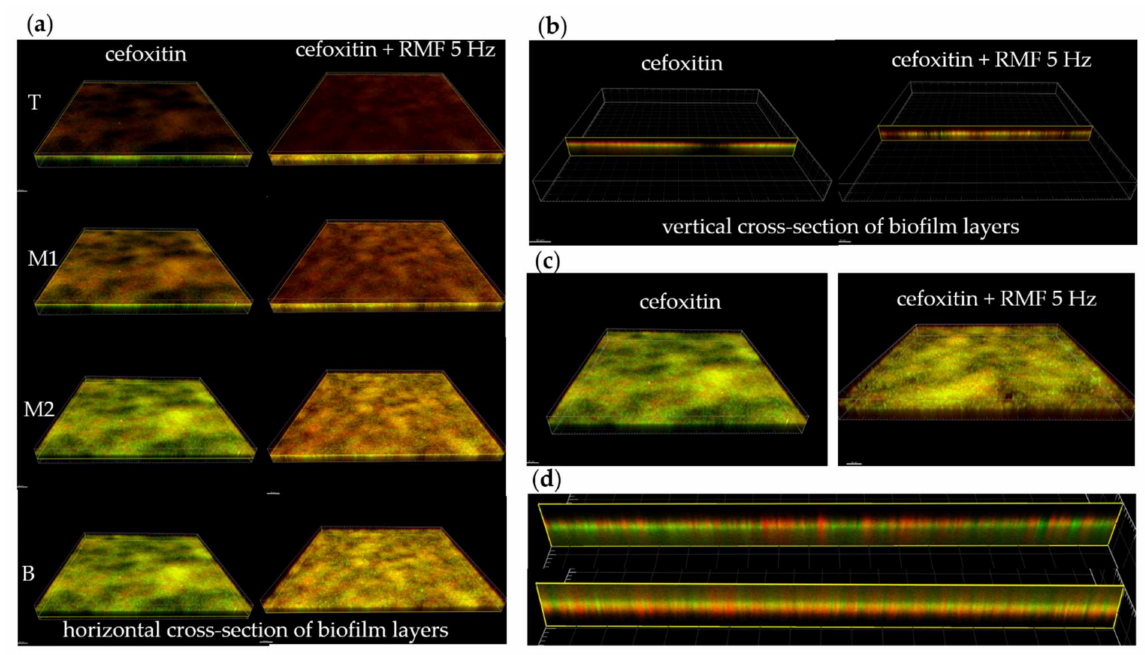
Figure 4. The distribution of staphylococcal cells with intact walls (green color) and with altered walls (red/orange color) in the biofilm of MRSA ATCC 33591 strain; ( a ) horizontal cross-sections of top, middle and bottom (T, M1, M2, B, respectively) layers of biofilm exposed to cefoxitin (left part) or cefoxitin coupled with the RMF of 5 Hz (right part); ( b ) vertical cross-section through biofilm layers treated with cefoxitin only (left part) or cefoxitin and RMF of 5 Hz (right part); ( c ) a stack of recorded cell layers in biofilm in settings where cefoxitin only or cefoxitin with RMF of 5 Hz were used; ( d ) distribution of cells with intact or altered walls in the biofilm unexposed to RMF and the antibiotic (upper part) and exposed to RMF of 5 Hz (lower